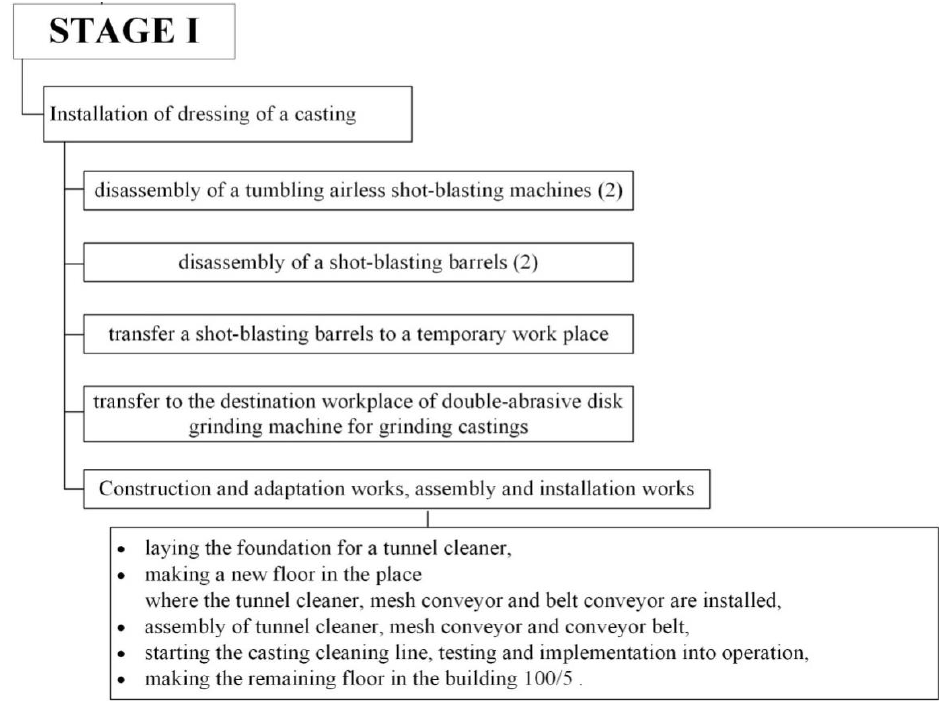
Figure 7. The first stage of modernization of the casting process. Metals 2019 , 9 , x FOR PEER REVIEW